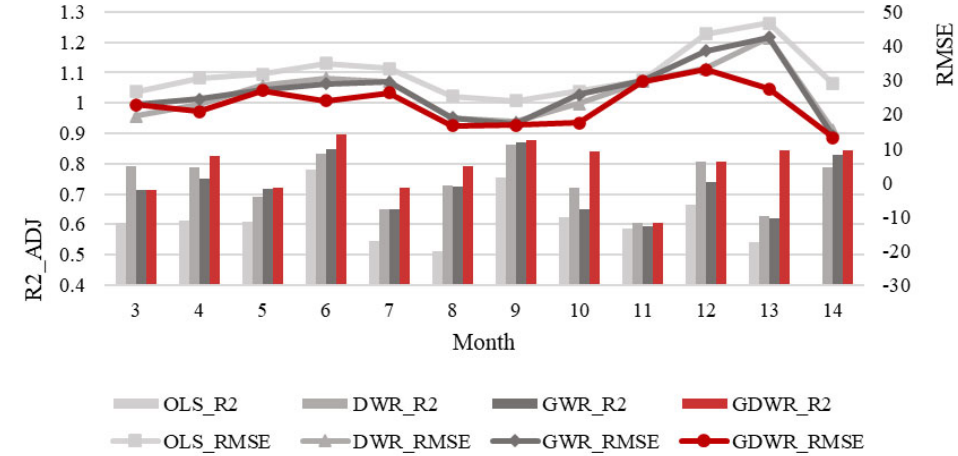
Figure 8. Comparison of the monthly model fitting accuracy among the OLS, DWR, GWR, and GDWR models.